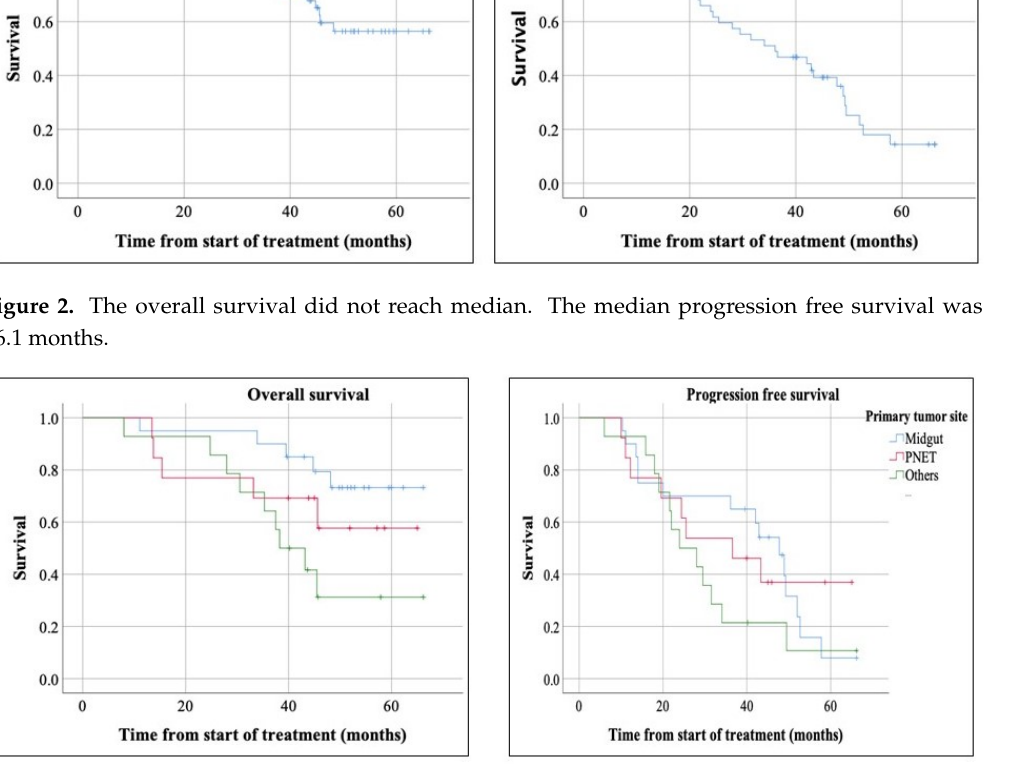
Figure 3. Overall survival (OS) and Progression-free survival (PFS) based on tumor types. The median OS was significantly longer in patients with midgut neuroendocrine tumors (NETs) ( p -value = 0.039). Estimated median PFS was 47.7 months in midgut NETs, 36.5 in pancreatic NETs, and 23.9 months in other types of NETs, which the difference was not statistically significant ( p -value = 0.35).